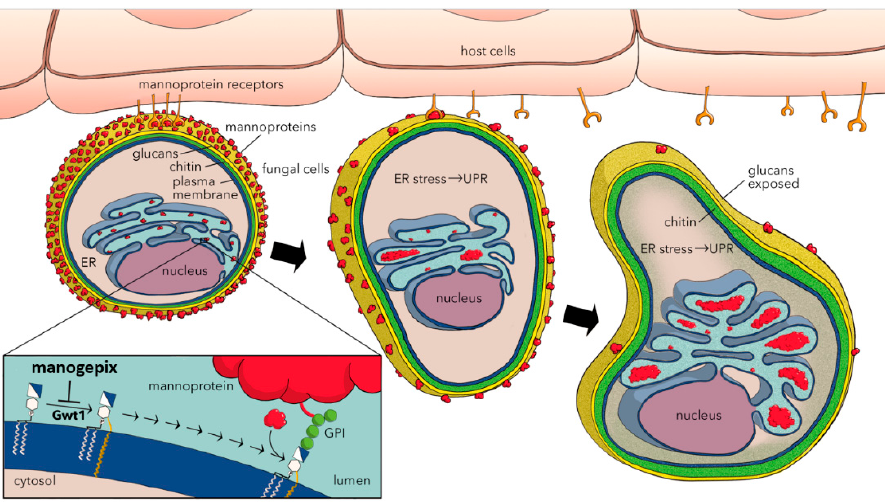
Figure 2. The mechanism of action of manogepix. Modified from 2019 Covel et al. [26]. Gwt1 is an enzyme which catalyzes an acyl group transfer reaction, an essential part of the GPI biosynthesis pathway. This occurs in the lumen of the endoplasmic reticulum. Gwt1 catalyzes the inositol acylation of glucosaminyl phosphatidylinositol (GlcN-PI), resulting in the formation glucosaminyl(acyl)phosphatidylinositol (GlcN(acyl)PI), an intermediate in the biosynthesis of GPI anchors.